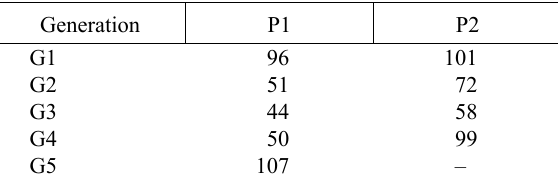
Table 3. The development time (days) for subsequent genera- tions (G1–G5) of Temora longicornis at stations P1 and P2 Generation P1